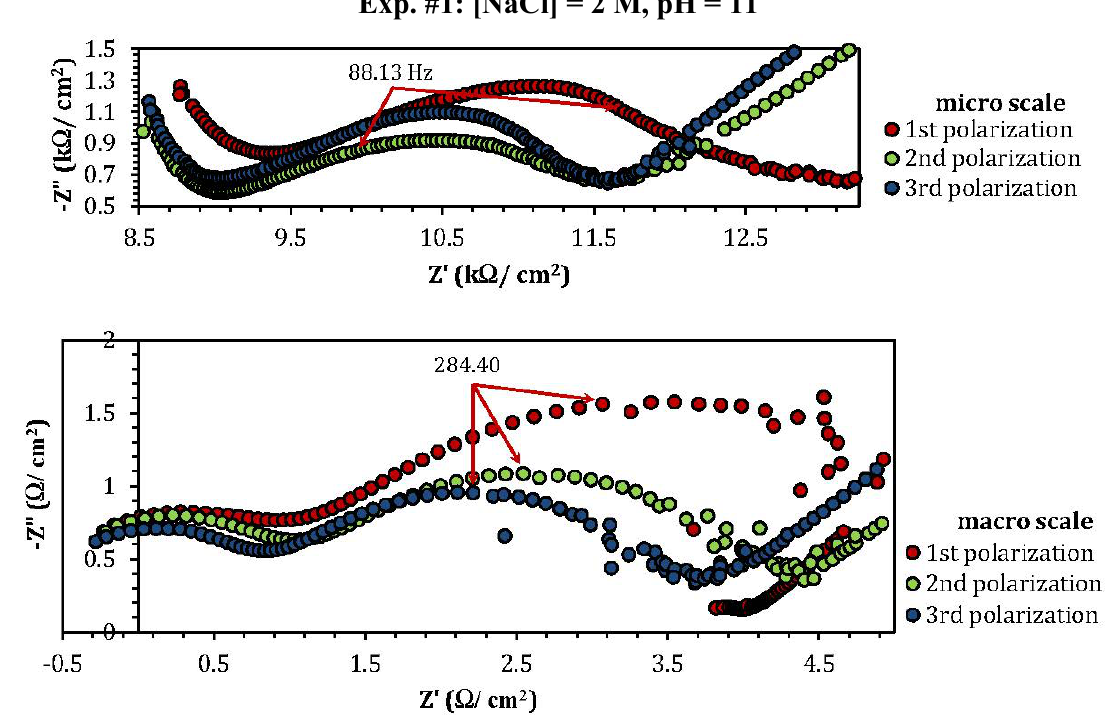
Figure 7. Micro and macro scale Nyquist diagrams of pure copper measured in NaCl solutions at different concentrations and pH values after three continuously potentiodynamic polarizations. Exp. #1: [NaCl] = 2 M, pH =